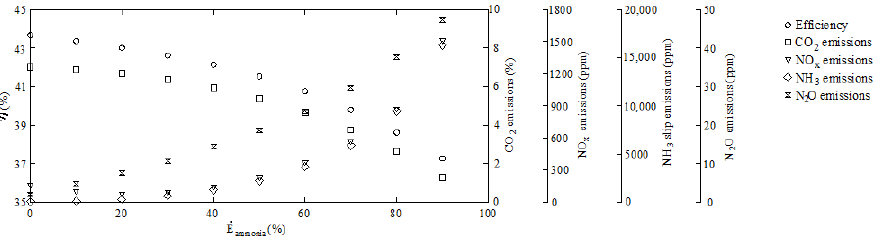
Figure 1. Efficiency and emissions of CO 2 , NO x , NH 3 , and N 2 O under dual fuel ammonia/diesel in the MAN D2840LE V10 engine. Adapted from [33].